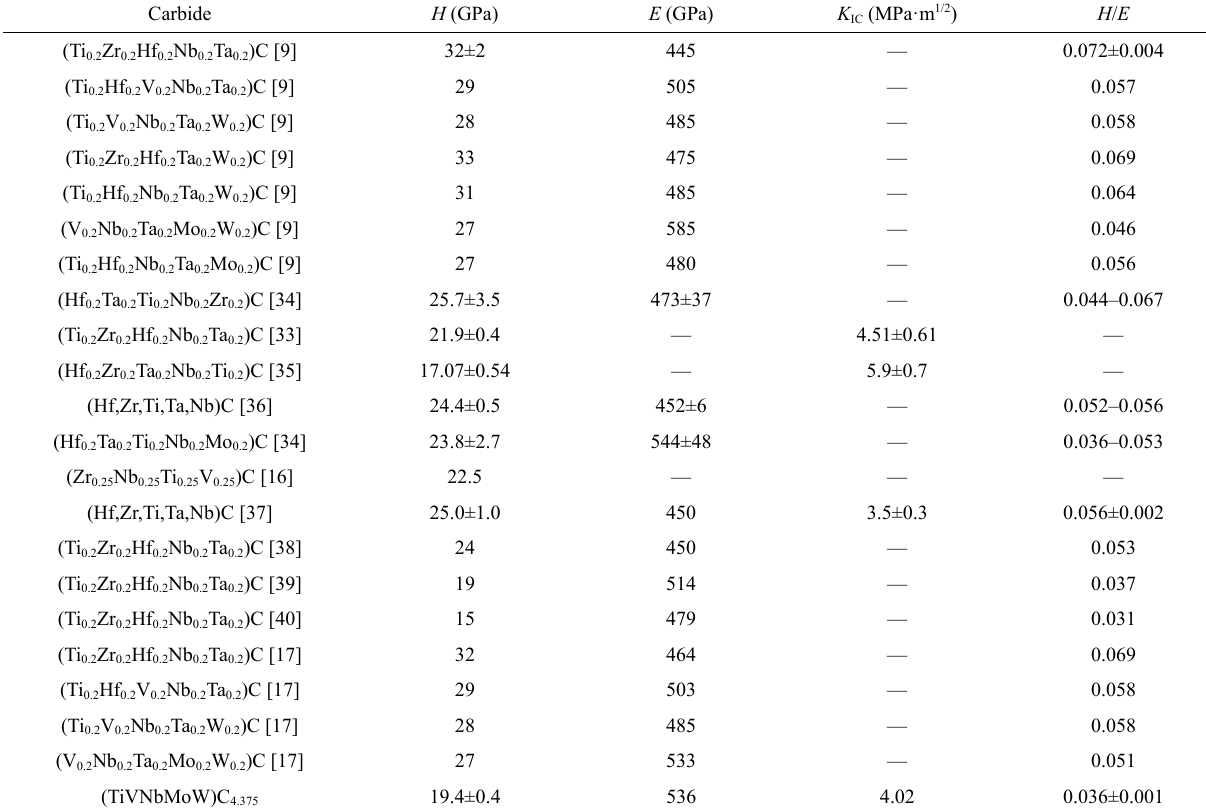
Table 2 Comparison of mechanical properties of high-entropy (TiVNbMoW)C 4.375 with those of other high-entropy carbides